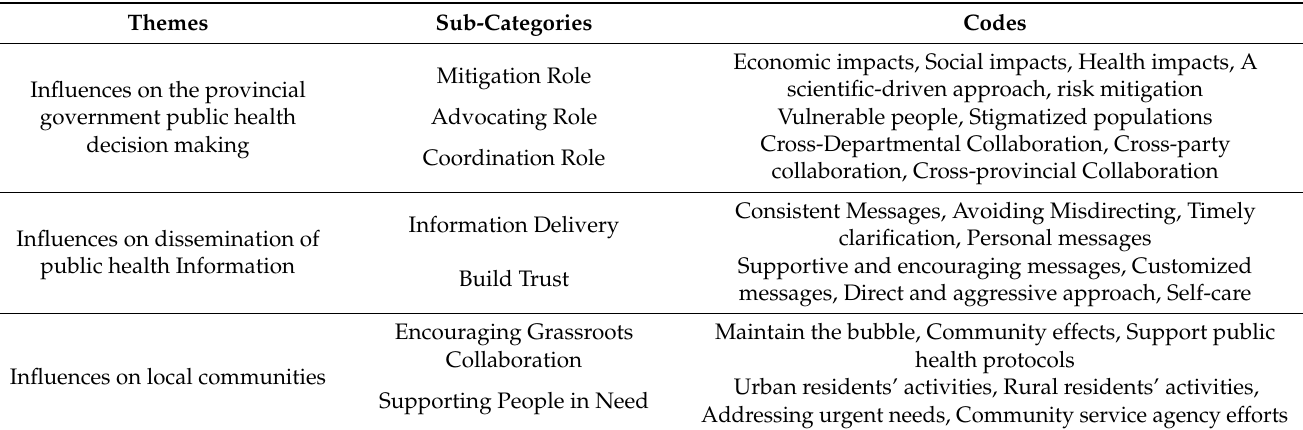
Table 3. Themes, sub-categories, and